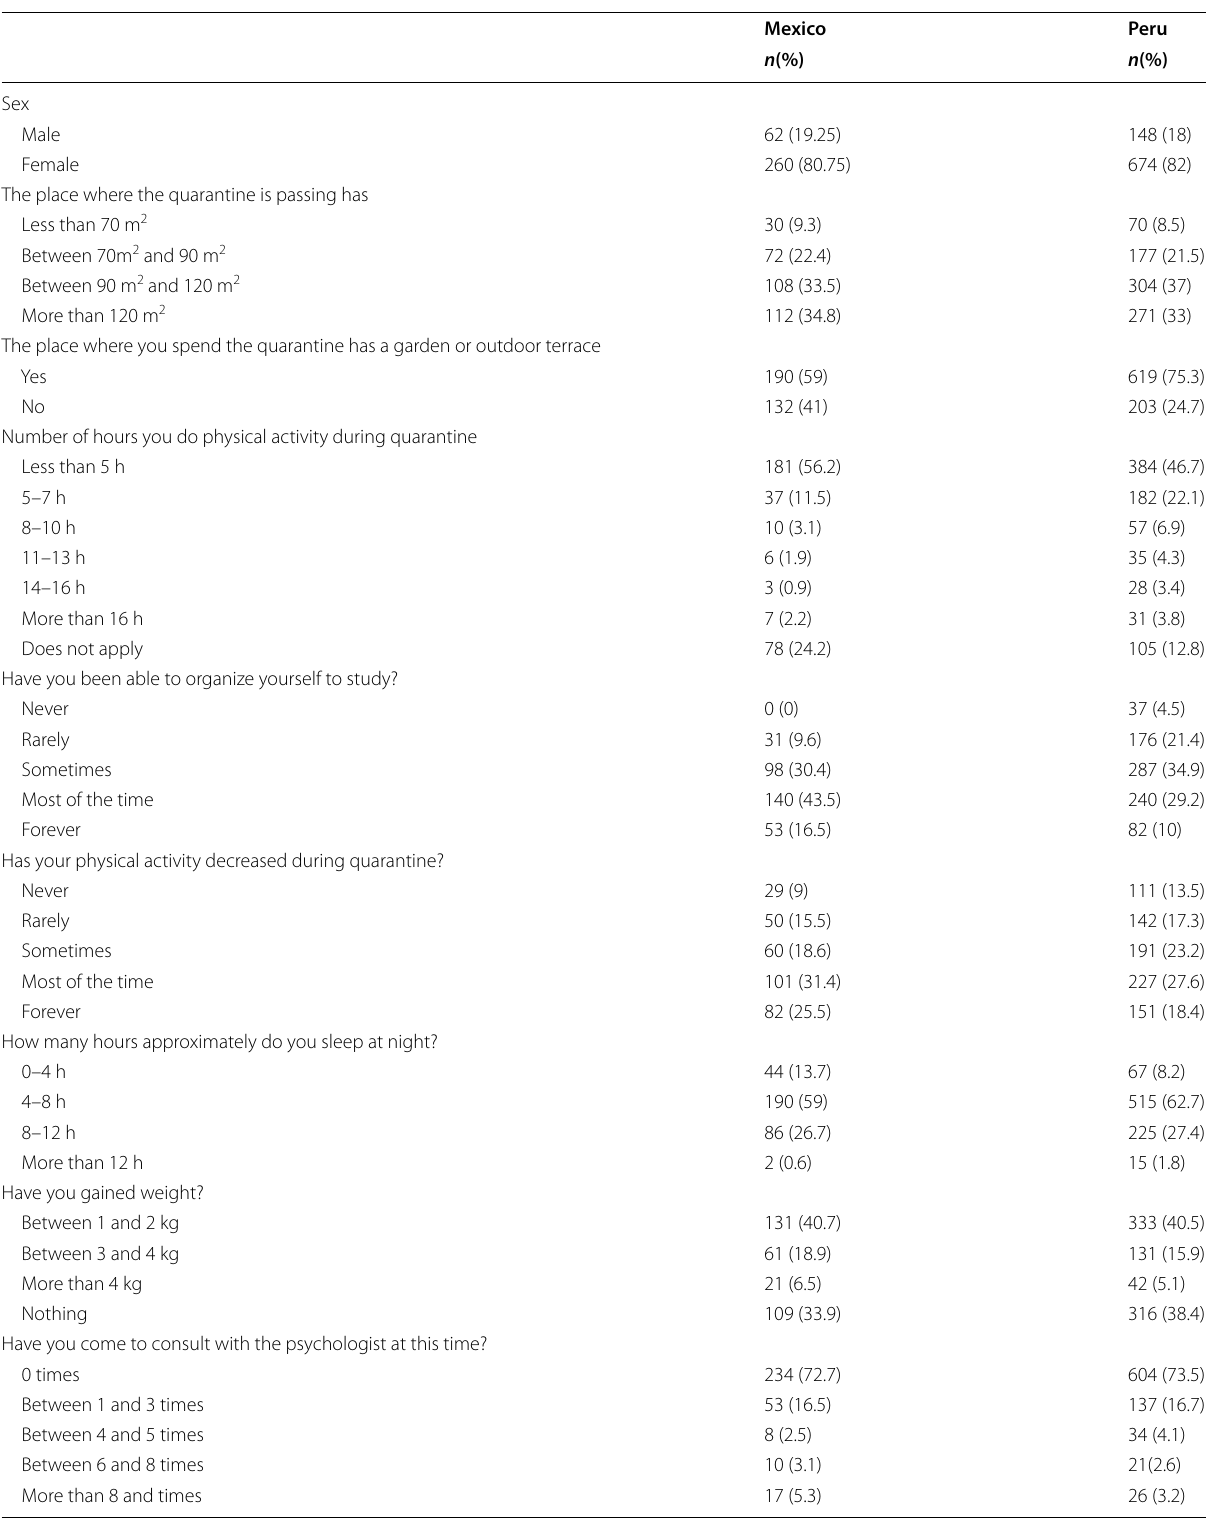
Table 1 Sociodemographic characteristics of the samples from Peru and Mexico